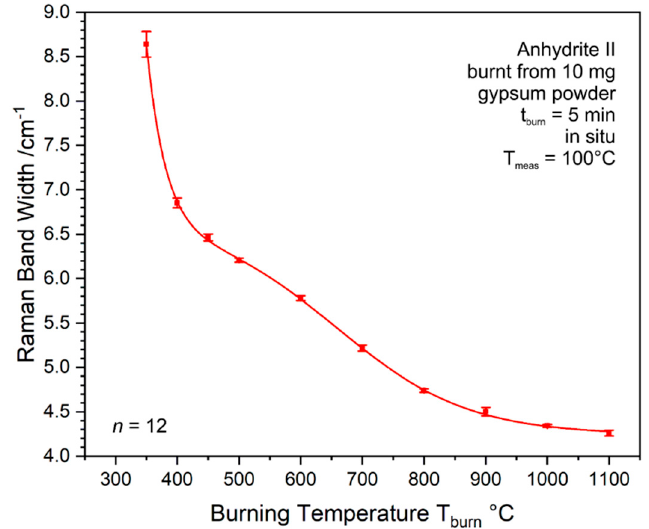
Figure A3. Double-sigmoidal function fitted to Raman band widths data of anhydrite II from in situ measurements.